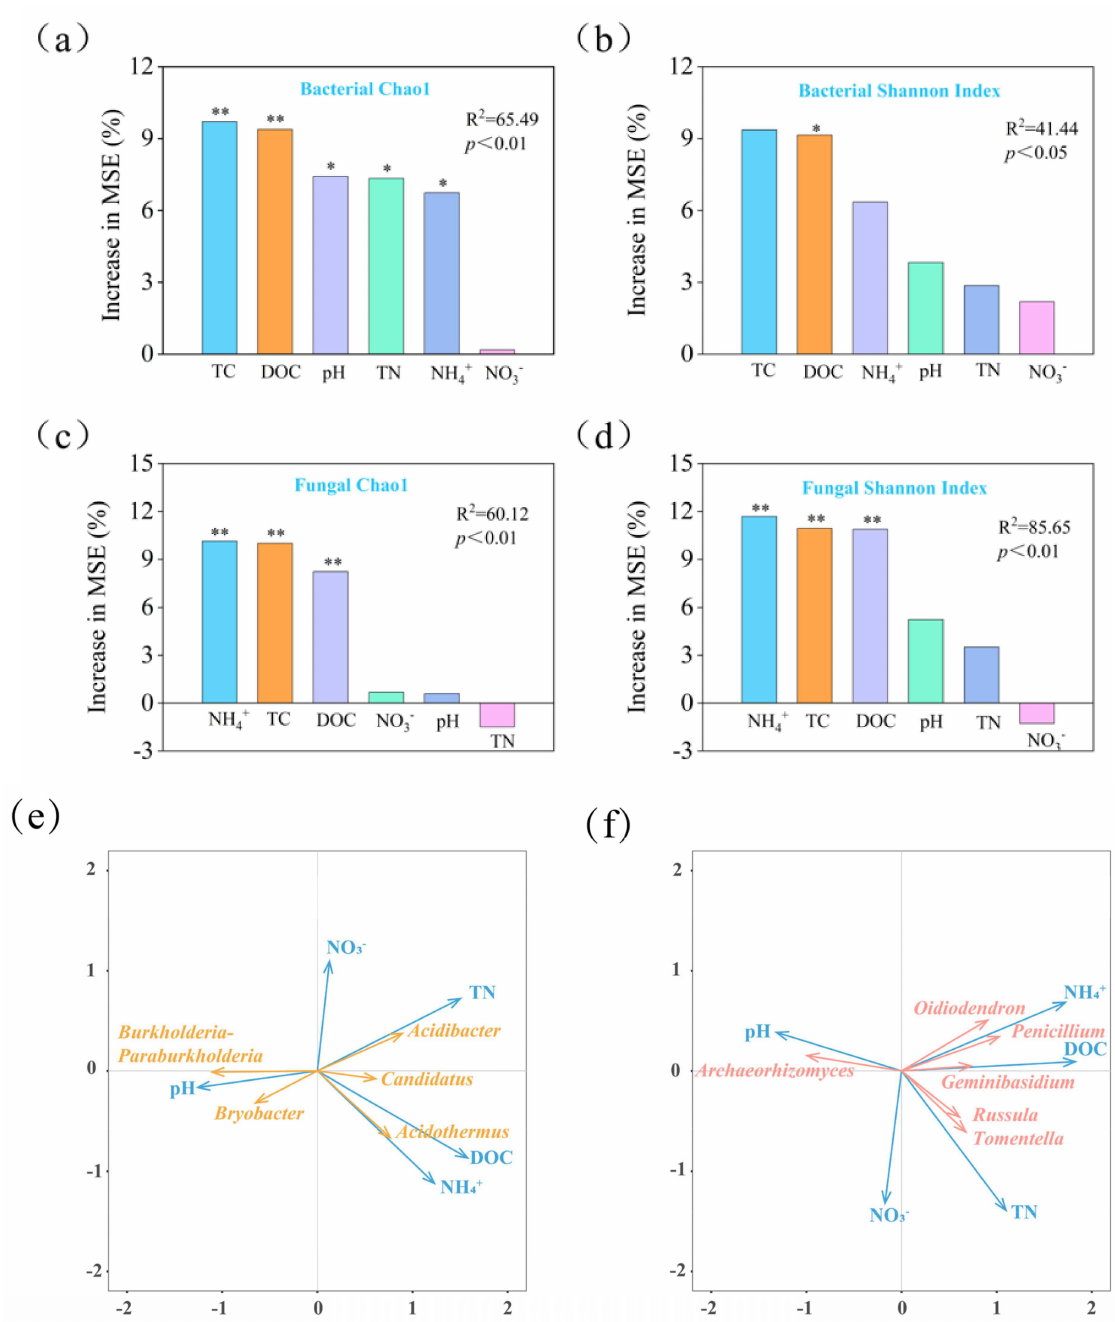
Figure 5. Random forest plot between soil environmental factors (TC, DOC, pH, TN, NH 4+ , and NO 3 − ) and soil microbial alpha diversity (Chao1 and Shannon index), indicating the importance (percentage of increase in the mean squared error) of soil environmental factors for Chao1 bacteria ( a ), Shannon index bacteria ( b ), Chao1 fungi ( c ) and Shannon index fungi ( d ). Significance levels are * p < 0.05 and ** p < 0.01. MSE, mean squared error. Redundancy analysis ordination maps based on the relative abundance of soil bacterial genus ( e ) and fungal genus ( f ) exceeding 1%. Bacteria (orange arrows) and fungi (pink arrows) and environmental variables (blue arrows). TN: total nitrogen; TC: total carbon; DOC: dissolved organic carbon; NO 3 − : nitrate nitrogen; NH 4 + : ammoniacal-nitrogen; pH: the potential of